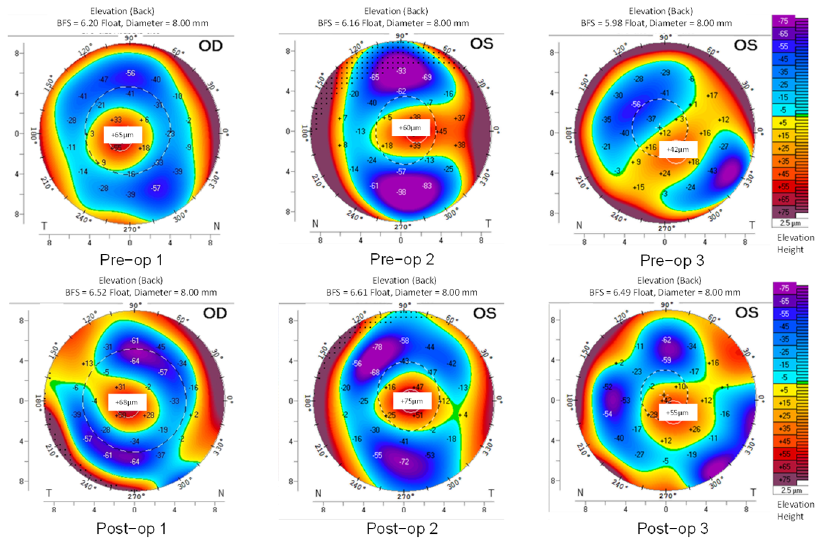
Figure 2. ELE-back maps based on Pentacam-derived topometric data for three representatives of the KCN group before (pre-op) and after (post-op) the intracorneal implantation within 8 mm diameter of the corneas (the horizontal and the vertical axis). The color-coded scale is identical in all images.